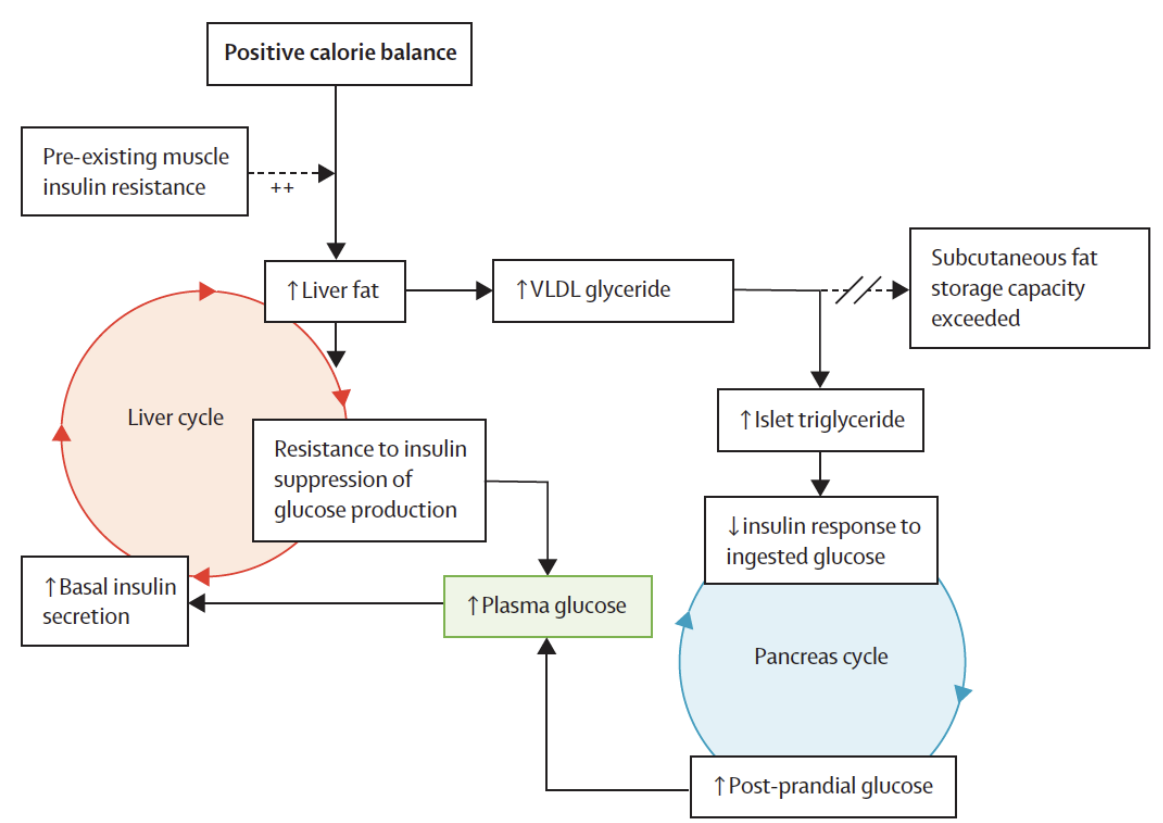
Figure 2. Twin cycle hypothesis. During chronic positive calorie balance, the de novo lipogenesis pathway handles carbohydrates which cannot be stored as glycogen, promoting fat accumulation in the liver. Because the process is stimulated by insulin, individuals with a degree of insulin resistance (determined by genetic or lifestyle factors) accumulate liver fat more readily than others due to the higher plasma insulin concentrations. Consequently, the increased liver fat causes resistance to insulin suppression of hepatic glucose production. Over many years, a small increase in fasting plasma glucose leads to increased basal insulin secretion to maintain euglycemia. The consequent hyperinsulinaemia further increases the conversion of excess calories into liver fat. A vicious cycle of hyperinsulinaemia and blunted suppression of hepatic glucose production is thereby established. Fatty liver leads to increased export of VLDLs triglyceride into the circulation (and thus excess ectopic fat in the blood), which increases fat delivery to all tissues, including the pancreatic islets. This process is further stimulated by increased plasma glucose concentrations. Excess fatty acid availability in the pancreatic islets would be expected to impair the acute insulin secretion in response to ingested food, and at a certain level of fatty acid exposure, post-prandial hyperglycaemia supervenes. The hyperglycaemia further increases insulin secretion rates, with consequent increase in hepatic lipogenesis, spinning the liver cycle faster and driving on the pancreas cycle. Eventually the fatty acid and glucose inhibitory effects on the islets reach a trigger level, leading to β -cell failure and a fairly sudden onset of clinical diabetes. (Reprinted with permission from Taylor et al. [13]).